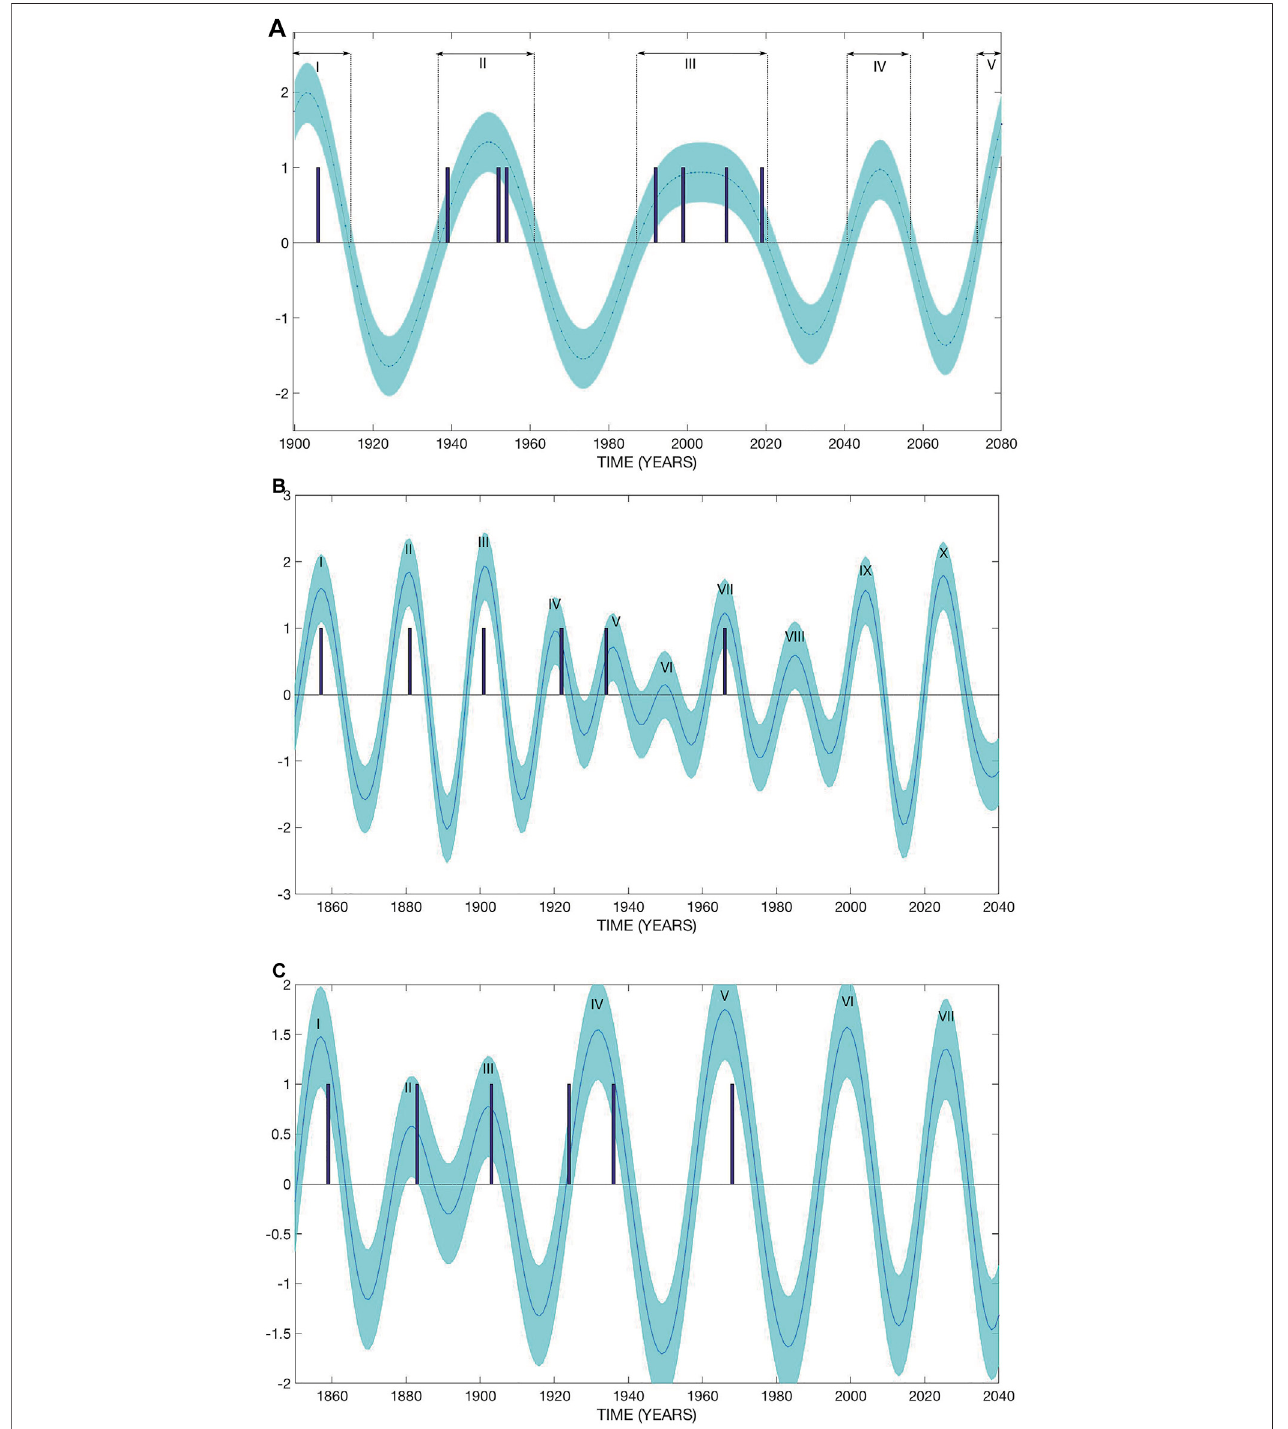
FIGURE 3 | (A) Probabilistic earthquake prediction for the southwestern United States and northern Mexico. Bayesian inference of LS-SVM model (blue line and shade)comparedwiththehistoricalearthquakesclusteredin3groups(I-III)andshownwithverticalbluebarsfrom1900to2021.Inaddition,theprobabilisticearthquake prediction is shown for the two future periods (cluster IV and V). The blue shaded area represents the 95% con fi dence intervals of the Bayesian model. Furthermore, we show and contrast the earthquake activity events at Park fi eld, California based on (B) the model proposed by Bakun and Lindh (1985) and (C) the results from our Machine Learning algorithm with the adopted periodicity of 35-years. Please see Section 4.1.1 for the discussion of the earthquake activity and event at Park fi eld, California.